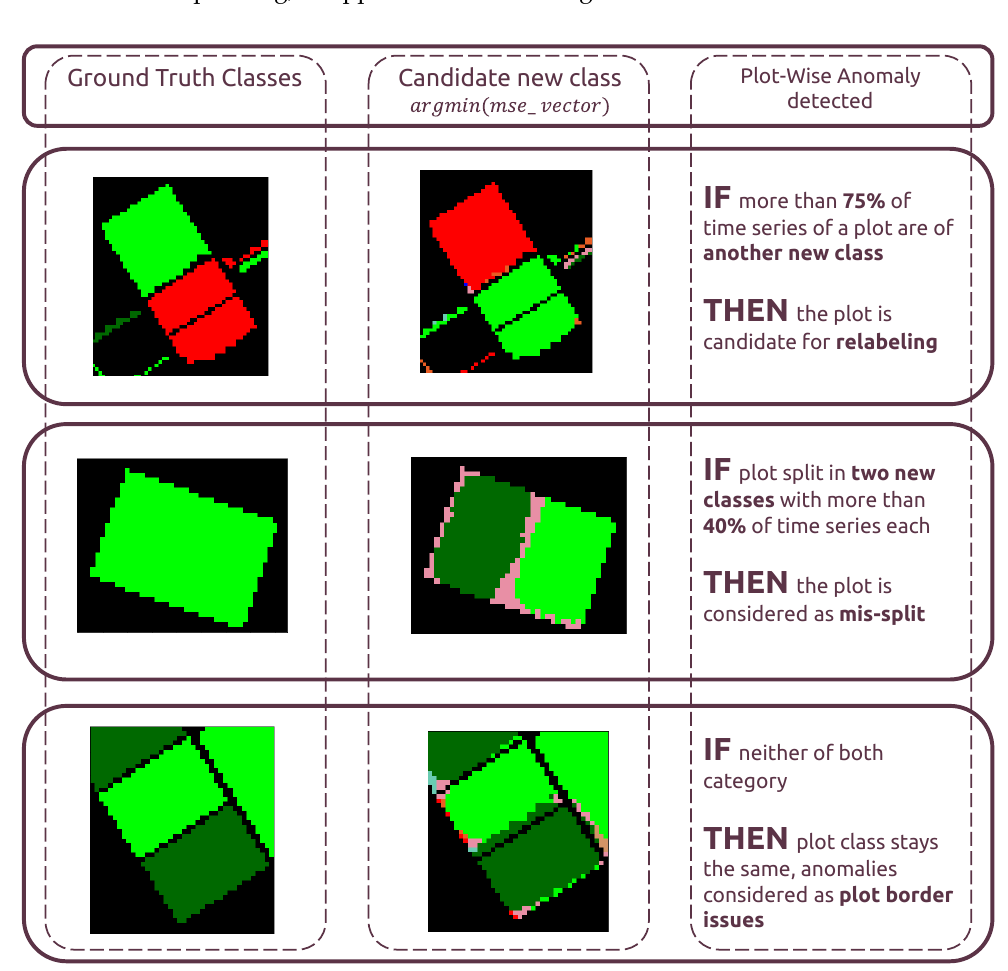
Figure 9. Plot-Level rule-based classification of anomalies. Class color code is the same as in Figure